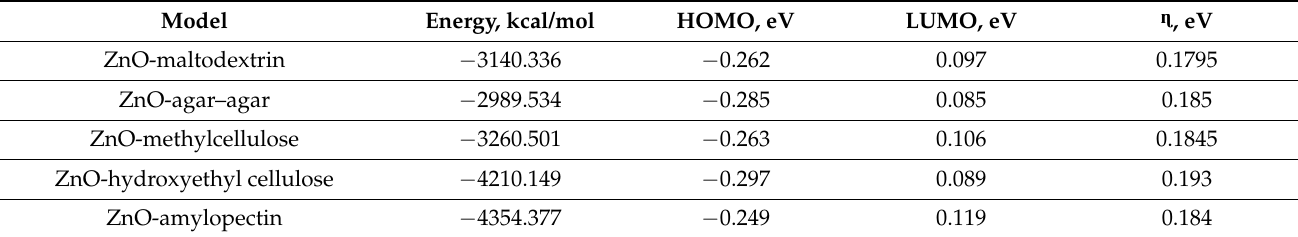
Table 2. Results of quantum chemical modeling.